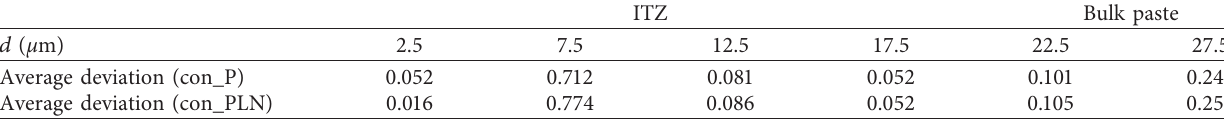
Table 7: Deviation of lower limit of ITZ Young’s modulus.